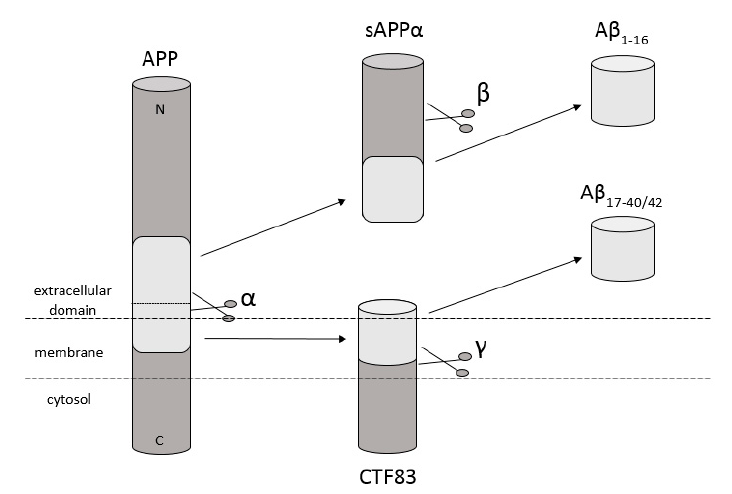
Figure 1 . Schematic diagram illustrating proteolytic cleavage of the APP in the non-amyloidogenic pathway, when APP is cleaved by α - and γ -secretase, respectively, and forms A β 17–40/42 , or when APP is cleaved by α - and β -secretase and forms A β 1–16 peptides. Based on [4].